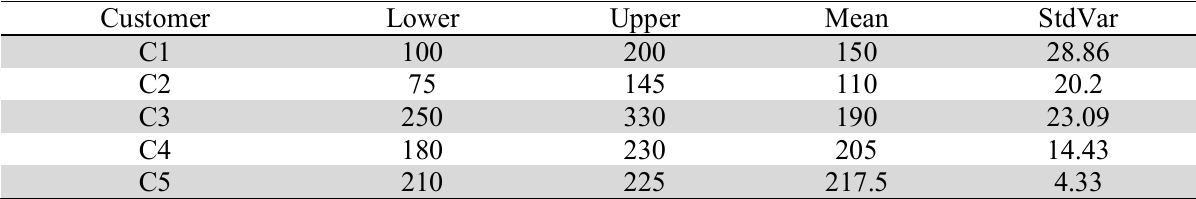
Customer Demand Distributions